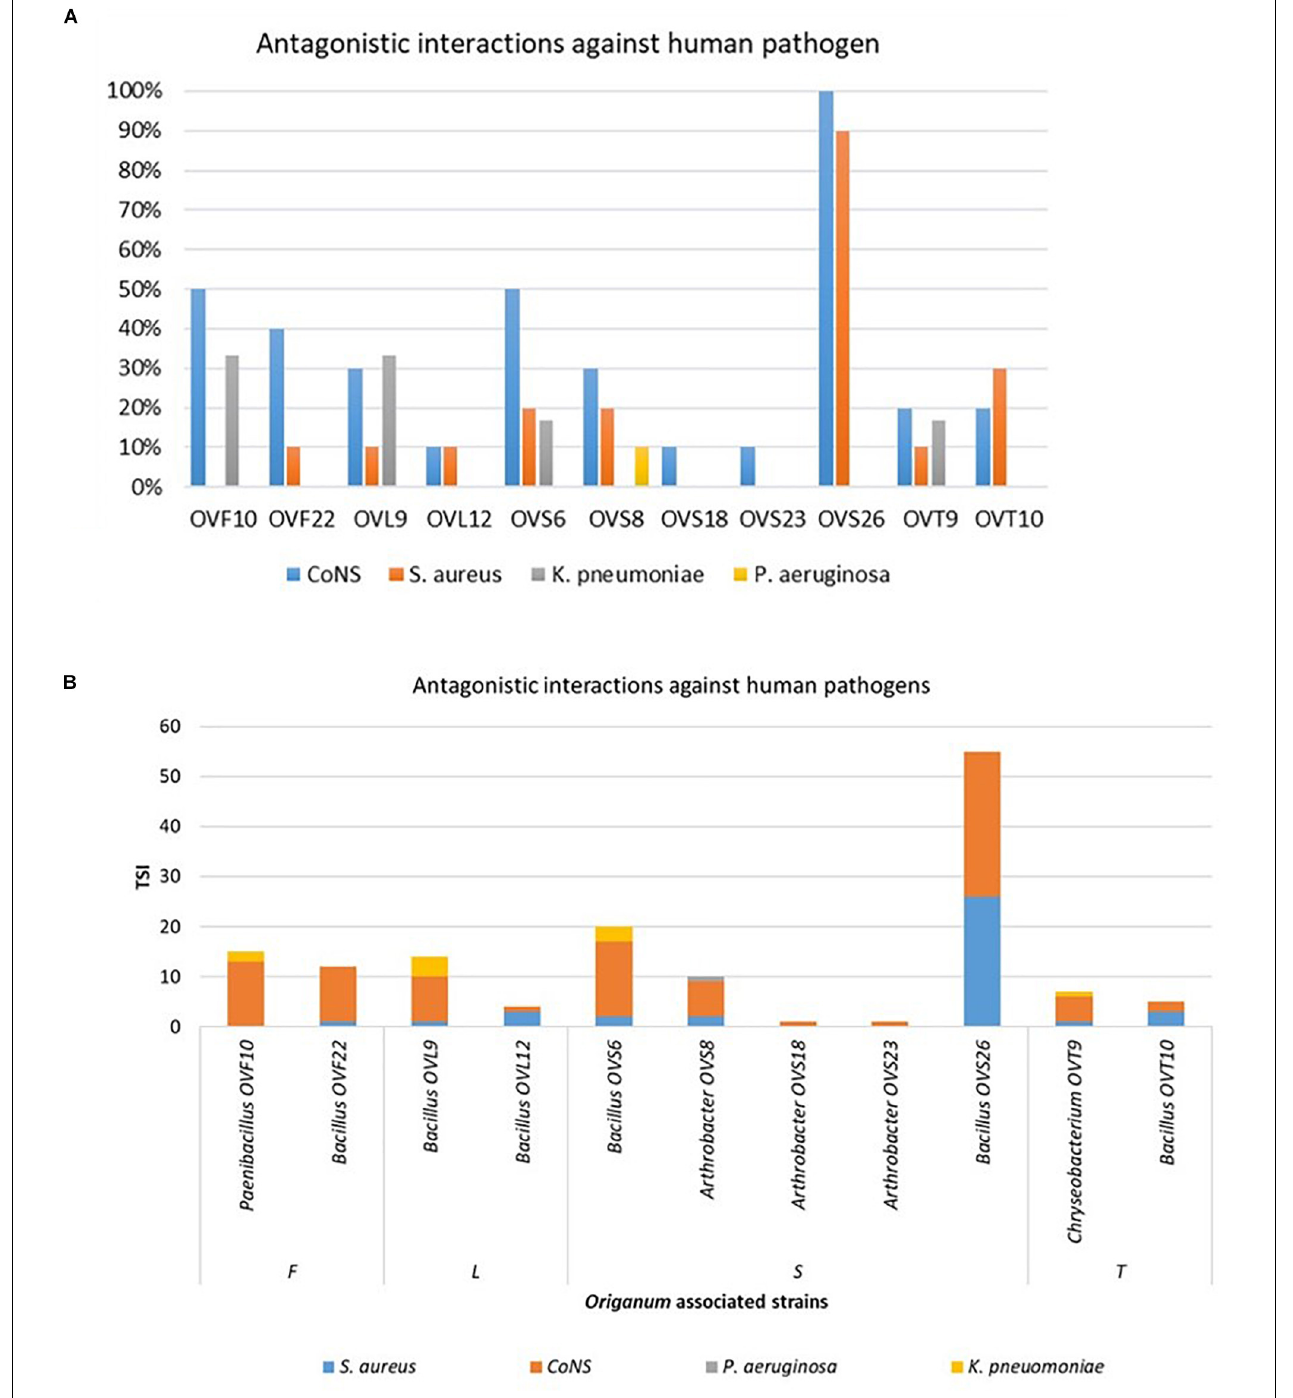
FIGURE 8 | Antagonistic activity exhibited by endophytes strains against human pathogenic bacteria ( S. aureus, CoNS, P. aeruginosa, K. pneumoniae ) expressed as percentage of the antagonistic activity (A) and TSI (B) .